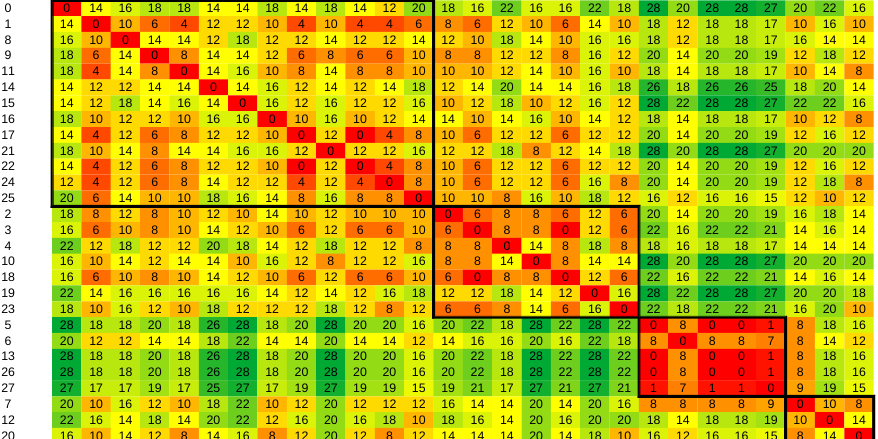
Figure 7. Distance matrix of the Levenshtein metric between daily activity vectors for the Kasteren dataset. Values are in thousands. The background color shows gradient changes in values, with red tones indicating low values and green tones indicating high values.